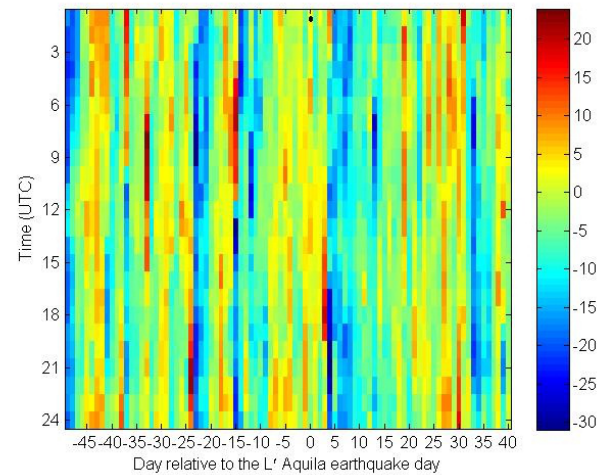
Fig.2. Changes of D st index in time interval corresponding to L’Aquila earthquake Fig. 2. Changes of D st index in time interval corresponding to L’Aquila